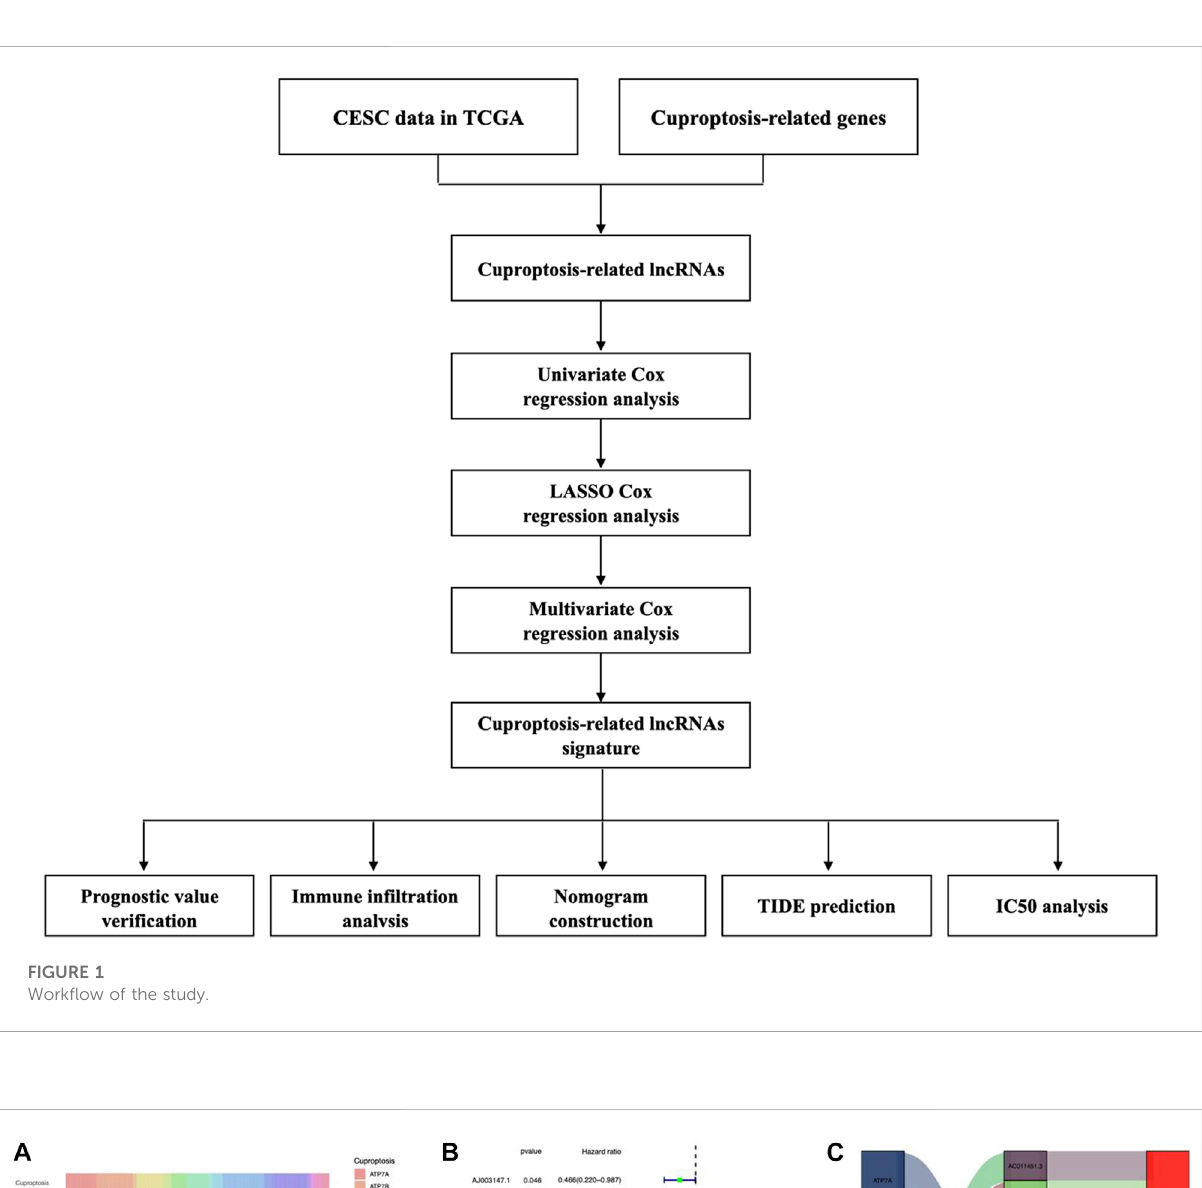
FIGURE 1 Work fl ow of the study.